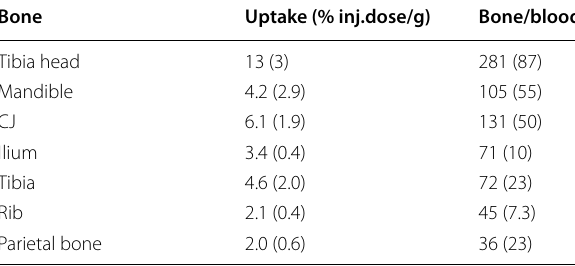
Table 1 Uptake as % of injected dose/gram of tissue (% inj. dose/g) and the bone‑to‑blood ratios of 18 F‑radioactivity detected ex vivo in different bones at 60 min after [ 18 F]NaF injection